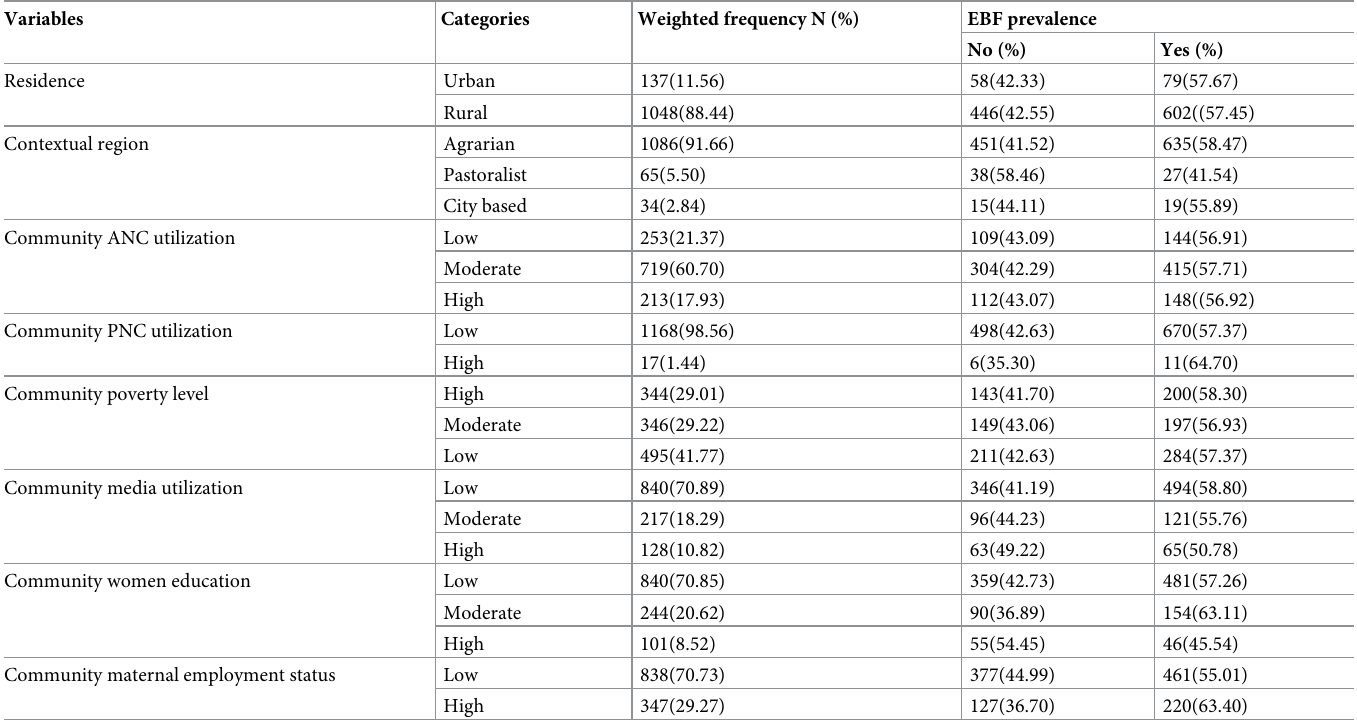
Table 4. Community- level determinants of exclusive breastfeeding in Ethiopia, 2016 (N =